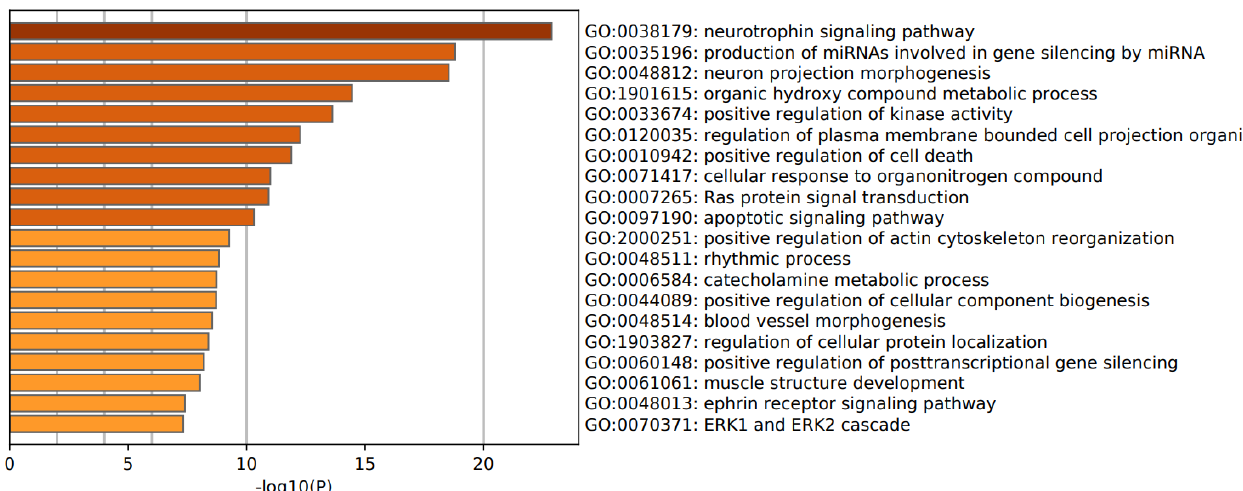
Figure 2. Heat map of enriched GO terms showing the top 20 biological functions overexpressed in the upregulated proteins of patients with first episode psychosis (accumulative hypergeometric p -values).